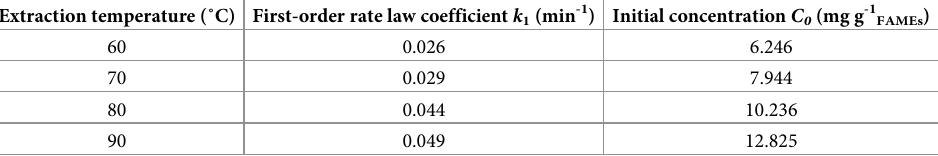
Table 1. First-order kinetic model for the extracted EPA from N . oceanica microalgae using